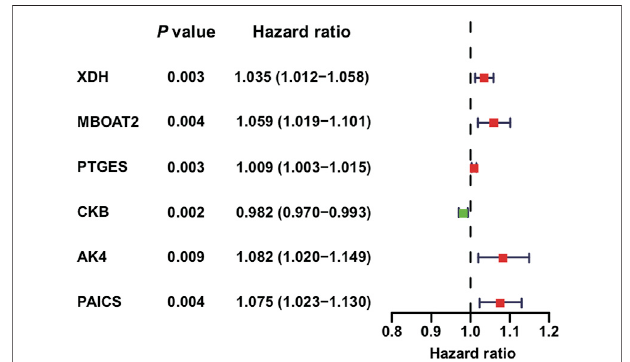
FIGURE 1 | Identi fi cation of PDEMRGs in PAAD using TCGA database: forest plot of six PDEMRGs obtained from univariable Cox regression analysis ( p ≤ 0.01): high-risk genes are represented in red (hazard ratios, HR > 1) and low-risk genes are represented in green (HR ≤ 1).